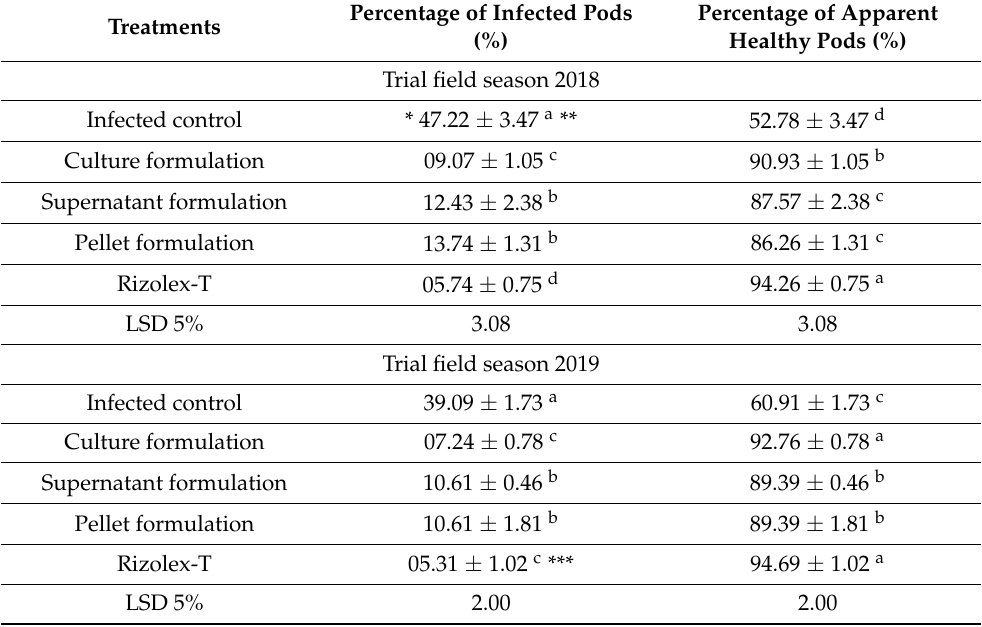
Table 7. Effect of treatment with talc-based formulations of Streptomyces cellulosae Actino 48 on percentage of infected pods of peanut under open-field conditions during seasons of 2018 and 2019. Percentage of Infected Pods Percentage of Apparent Treatments (%) Healthy Pods (%) Trial field season 2018 Infected